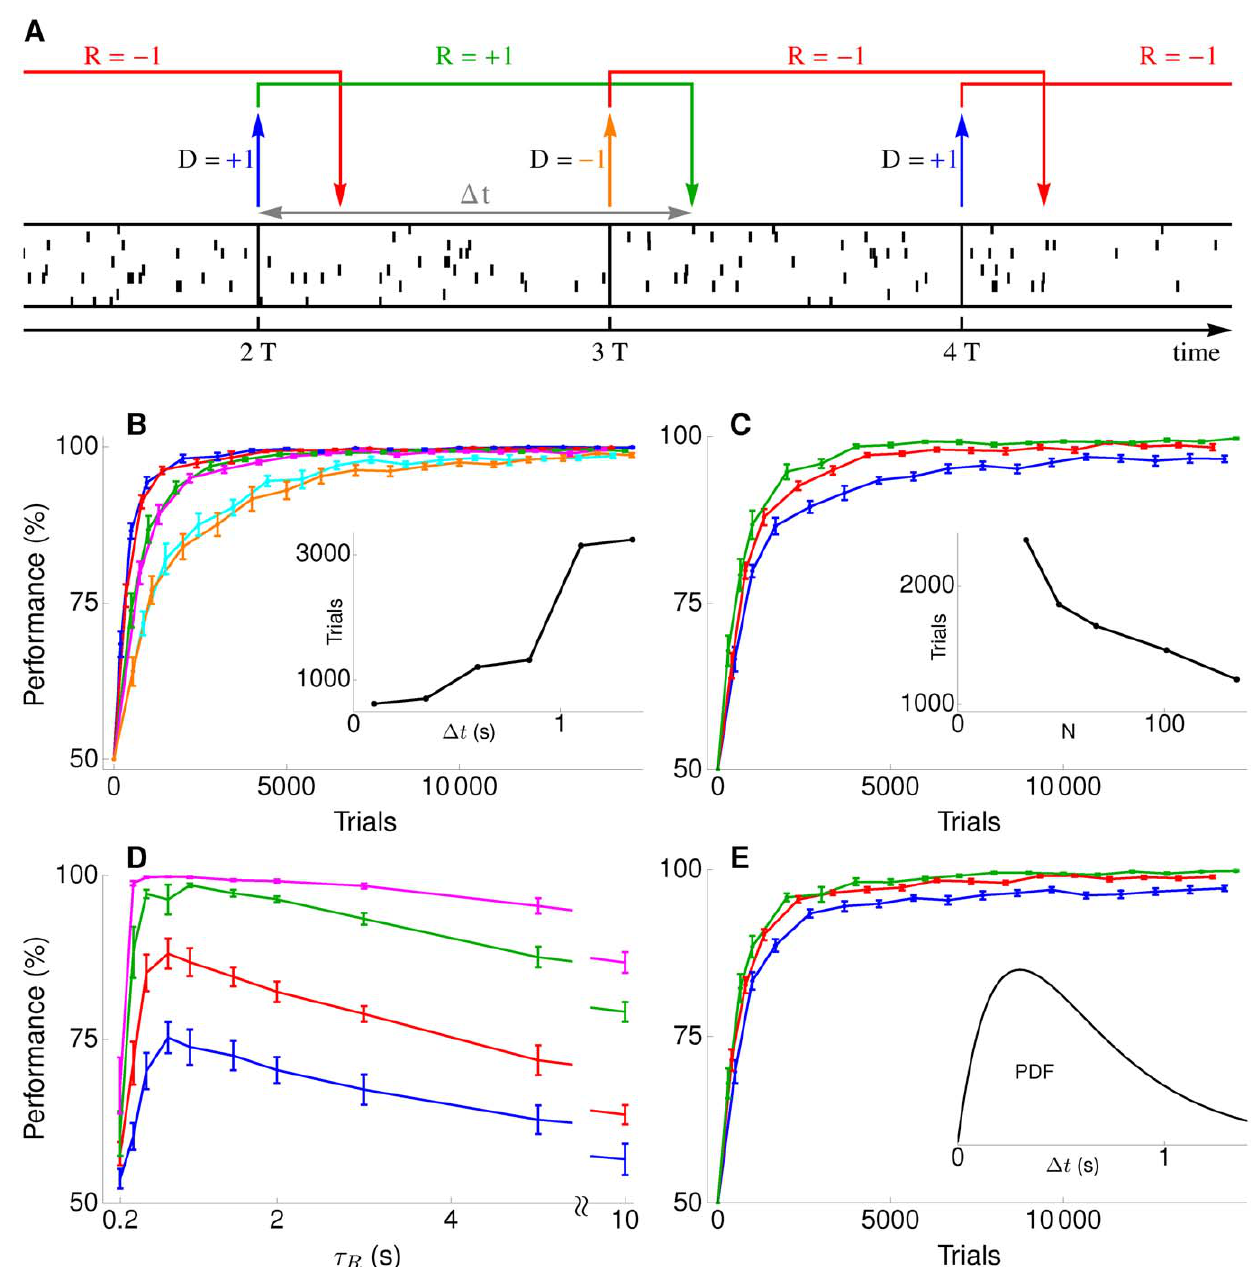
Figure 3. Stimulus-response association with delayed reinforcement. (A) Sketch of the task. After each stimulus (spike pattern of duration T ) a decision D ~ + 1 is taken and reward R ~ + 1 reflecting the correctness of the decision is delivered with a delay D t . (B) Performance, i.e. the percentage of correct decisions, achieved by a population with N ~ 135 neurons for different delays: D t ~ 100ms (blue), D t ~ 350ms (red), D t ~ 600ms (green), D t ~ 850ms (magenta), D t ~ 1100ms (cyan), D t ~ 1350ms (orange). The inset shows the number of pattern presentations required to reach a performance of 90% as function of the delay D t . (C) Performance vs. number of pattern presentations for a fixed delay D t ~ 600ms but with different population sizes: N ~ 33 (blue), N ~ 67 (red), N ~ 135 (green). Inset: Number of trials needed to reach 90% performance as function of the population size N . (D) Performance as function of the plasticity parameter t R representing a guess at the delay between decision and reward. The actual delay was D t ~ 600ms . Performance is plotted after 500 (blue), 1000 (red), 4000 (green) and 15000 (magenta) trials; the population size was N ~ 135 . (E) Results when the delay D t is no longer fixed but changes from trial to trial, being randomly chosen from the probability density shown in the inset. The mean delay is S D t T ~ 600ms . Learning parameters and color coding are as in Panel C. In all panels, error bars show 1 SEM of the mean. parameter b , called inverse temperature, modulates the level of Panel 4c shows that the average reward achieved by the TD- stochasticity in the decision making. TD-theory does not give a learner decreases with increasing b . So best performance is prescription for choosing b and, hence, we will consider a large obtained for b ~ 0 , i.e. when the choice valuations estimated range of values for the inverse temperature. The results in panels during learning are irrelevant. The probability p int of choosing the intermittent target increases with b , Panel 4D. The panel also 4C and 4D plot the asymptotic performance as function of b .